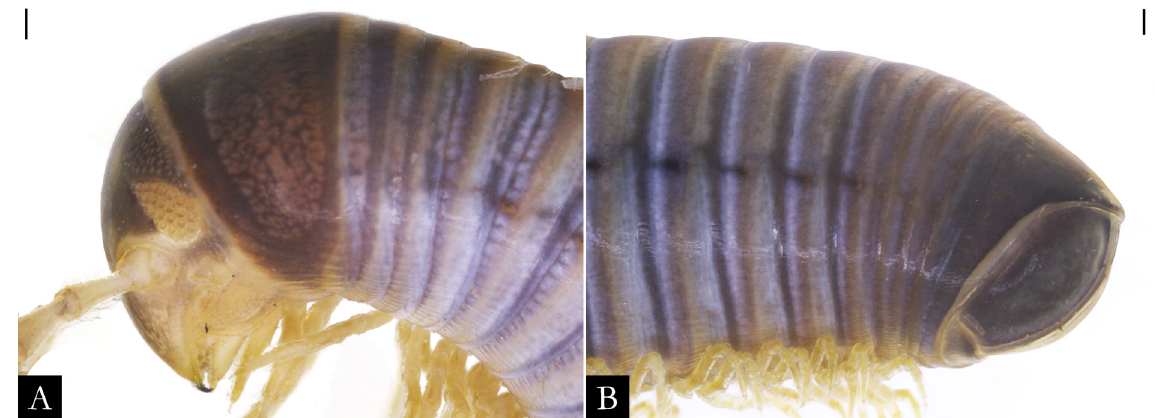
Fig. 149. Pseudonannolene bucculenta sp. nov., ♀ (IBSP 3350), in lateral view. A . Anterior region. B . Posterior region. Scale bars = 0.2